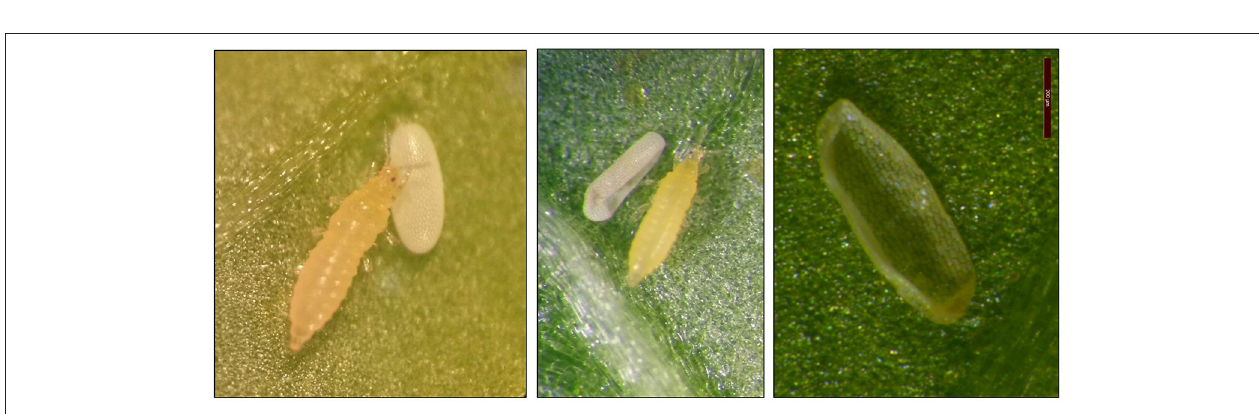
FIGURE 6 | Egg of S. rueppellii damaged by a F. occidentalis second instar